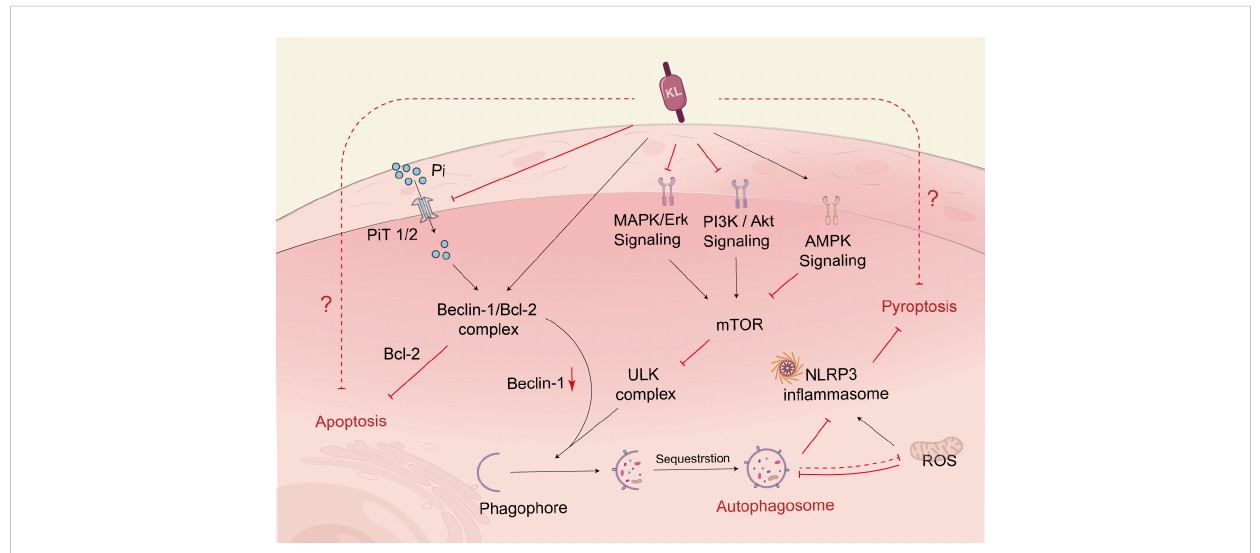
FIGURE 3 Klotho regulates cell death. Klotho regulates autophagic fl ux through PI3K/AKT/mTOR, MAPK, and AMPK pathways. Klotho can increase the binding of Beclin-1 to Bcl-2, reduce Beclin-1 ’ s interaction with other autophagy-related proteins, and thereby regulate autophagy. Additionally, Klotho indirectly upregulates autophagy by inhibiting the activity of NLRP3 in fl ammatory vesicles, which helps prevent renal tubular cell death. Klotho also indirectly regulates autophagy by controlling the excretion of Pi. PI3K, phosphoinositide 3-kinase; AKT, protein kinase B; mTOR, mammalian target of rapamycin; MAPK, mitogen-activated protein kinase; AMPK, adenosine monophosphate-activated protein kinase; NLRP3, nucleotide-binding oligomerization domain-like pyrin domain-containing protein 3; PiT, phosphate